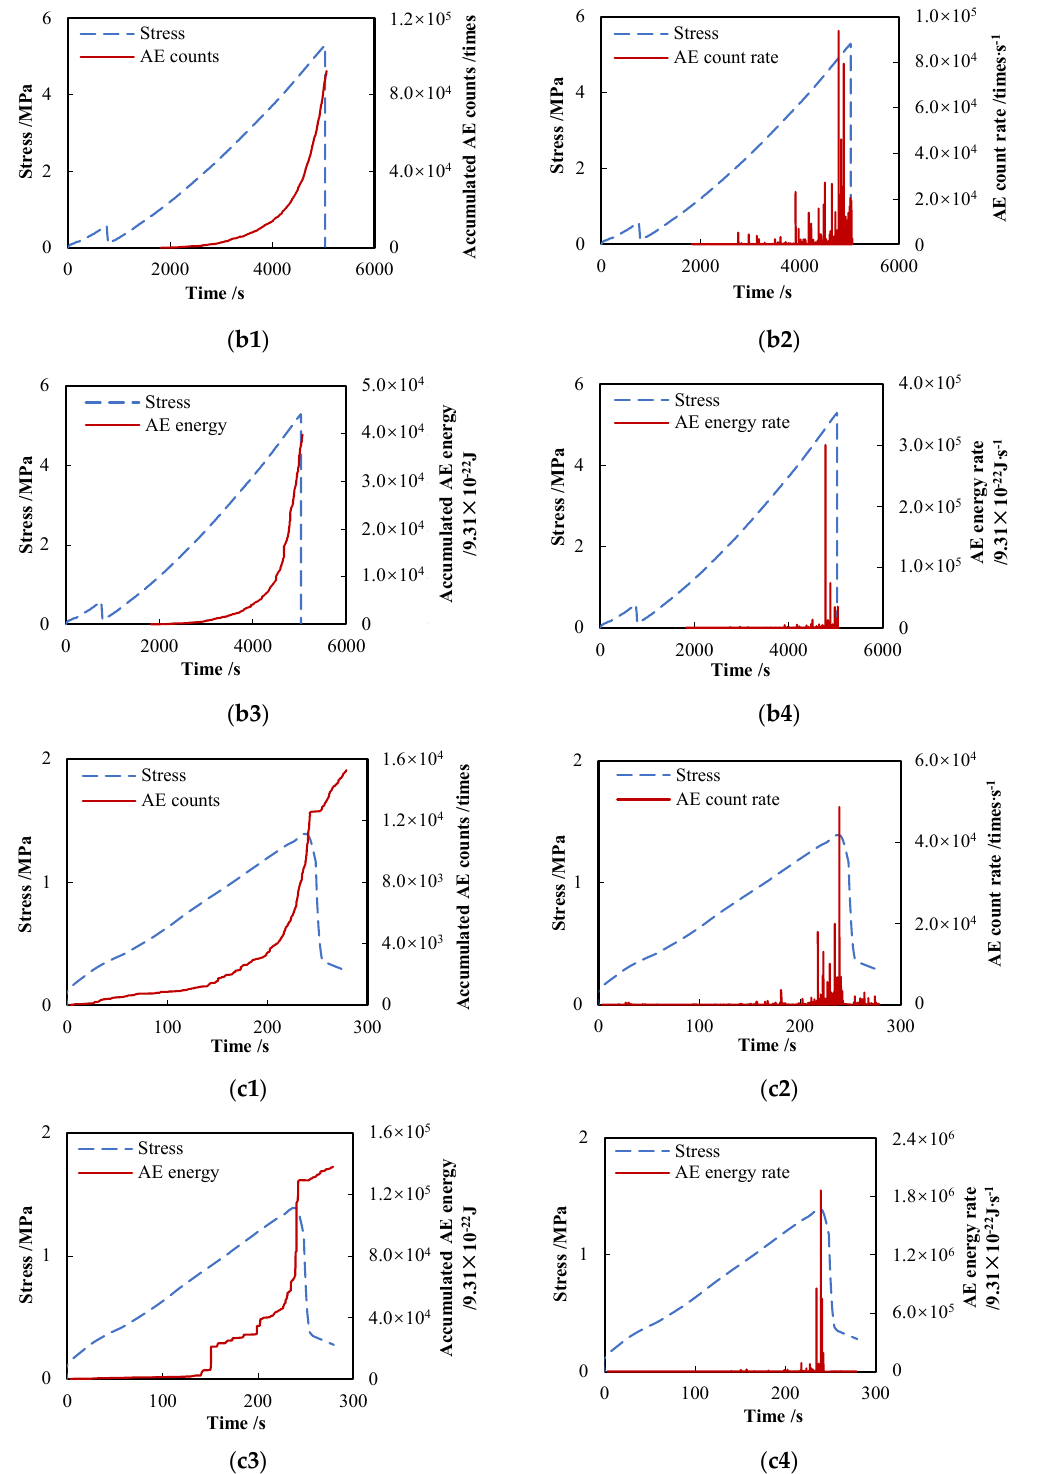
Figure 3. Temporal variation in the AE parameters of typical marble samples under different loading modes: ( a1 ) UCT (AE counts), ( a2 ) UCT (AE count rate), ( a3 ) UCT (AE energy), ( a4 ) UCT (AE energy rate), ( b1 ) DTT (AE counts), ( b2 ) DTT (AE count rate), ( b3 ) DTT (AE energy), ( b4 ) DTT (AE energy rate), ( c1 ) ITT (AE counts), ( c2 ) ITT (AE count rate), ( c3 ) ITT (AE energy), ( c4 ) ITT (AE energy rate).